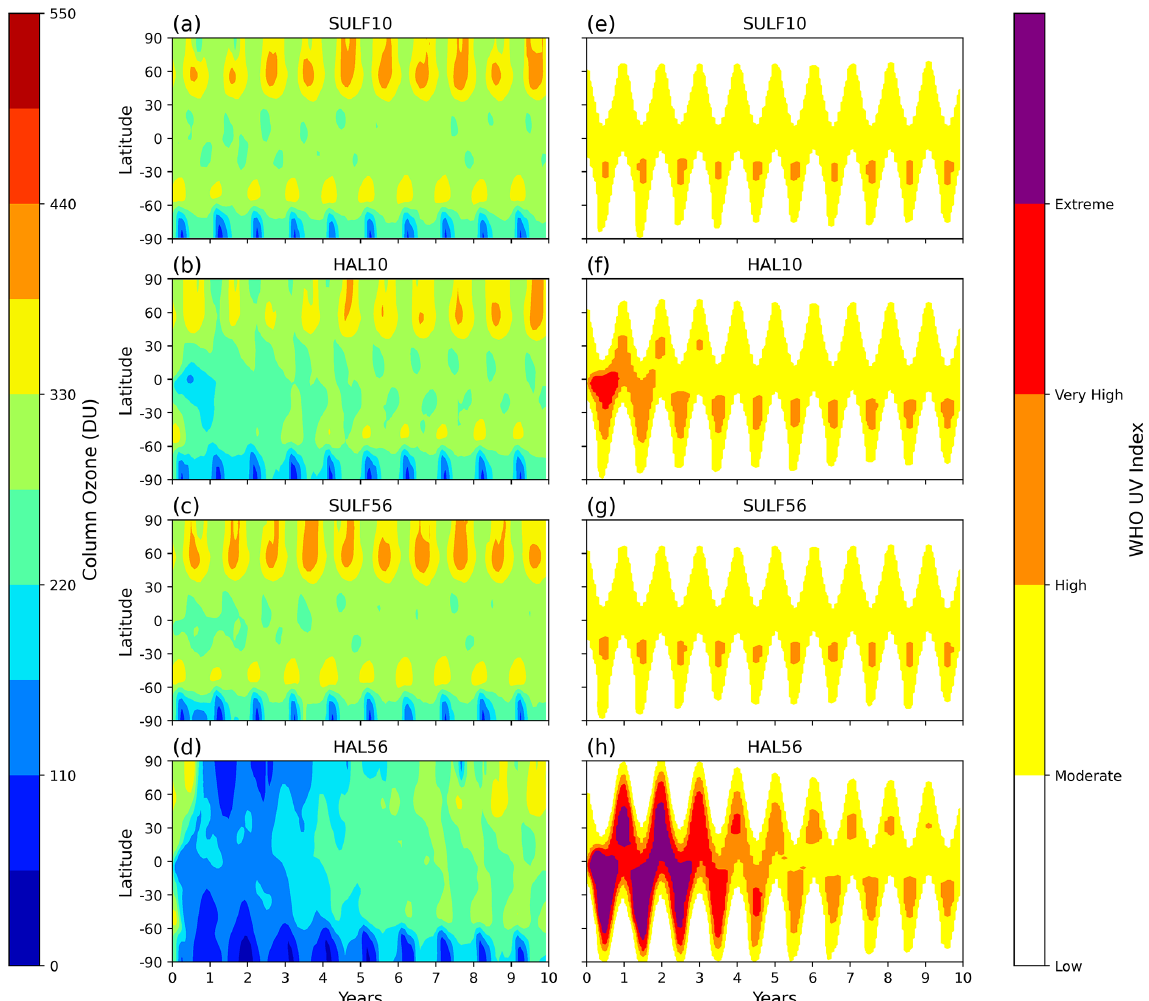
Figure 12. Zonal-mean column ozone: (a) SULF10, (b) HAL10, (c) SULF56, and (d) HAL56. Ozone hole conditions are simulated when the column ozone < 220DU. Zonal-mean surface UV exposure due to column ozone changes (WHO UV index): (e) SULF10, (f) HAL10, (g) SULF56, and (h)